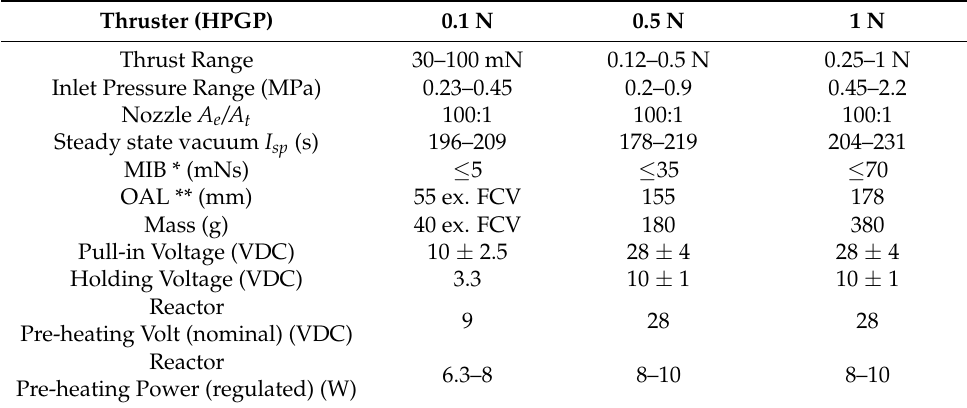
Table 13. HPGP thrusters: performance and specifications [59].